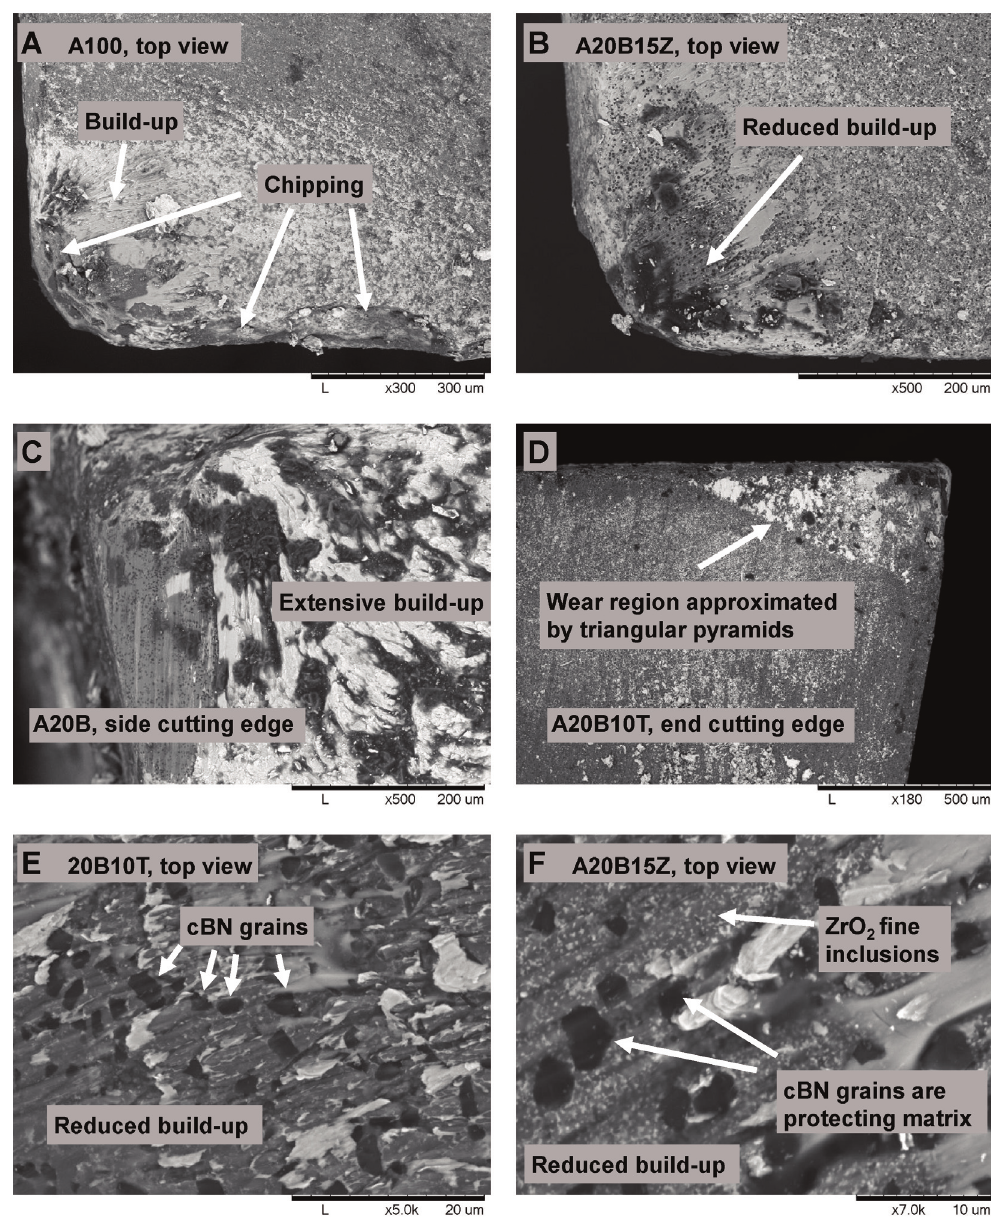
Fig. 5. Scanning electron microscope (SEM) images of the cutting tools ʼ worn surfaces. Please take the magnification into account in the comparison of